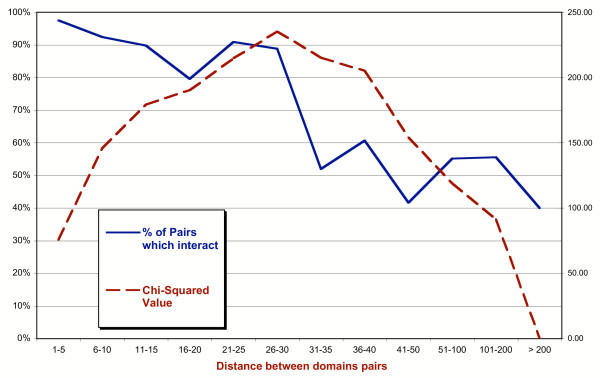
Distance between domain pairs on a protein chain and the likelihood that they interact The solid line indicates the percentage of domain pairs, within a distance range apart, which are in contact. The broken line shows the distribution of chi-squared values corresponding to constructed 2 × 2 contingency tables that classified domain pairs according to 2 criterions; 1) whether or not they are separated by a distance no greater than the upper limit of each range, and 2) whether or not the domain pair is interacting. The percentage of interacting domain pairs drop noticeably after 30 residues, and the chi-squared value is also maximum at this threshold.